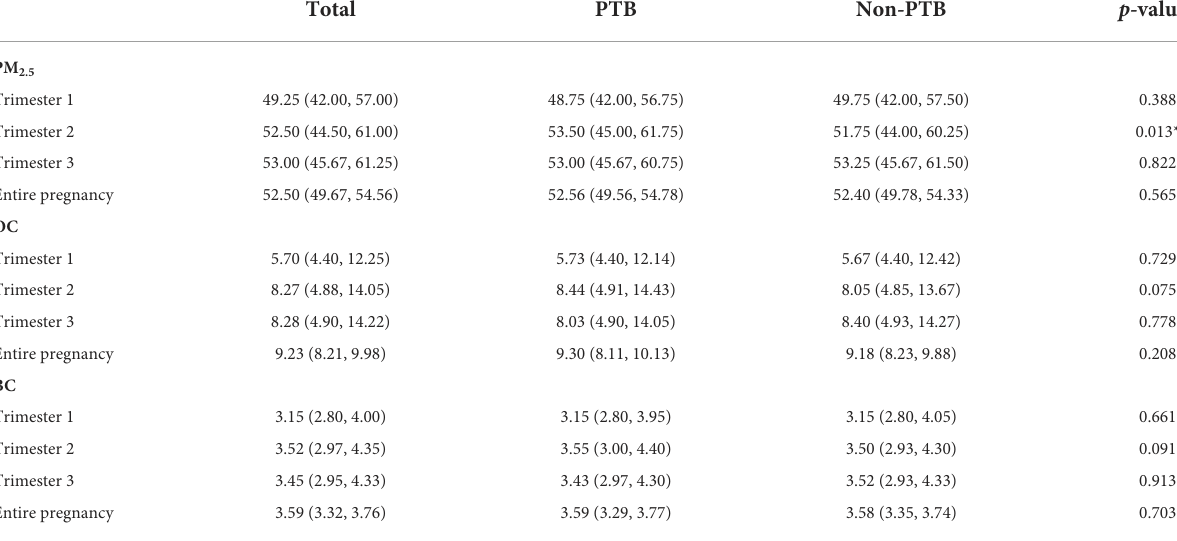
TABLE 2 Descriptive statistics of air pollution exposure levels ( µ g/m 3 ).